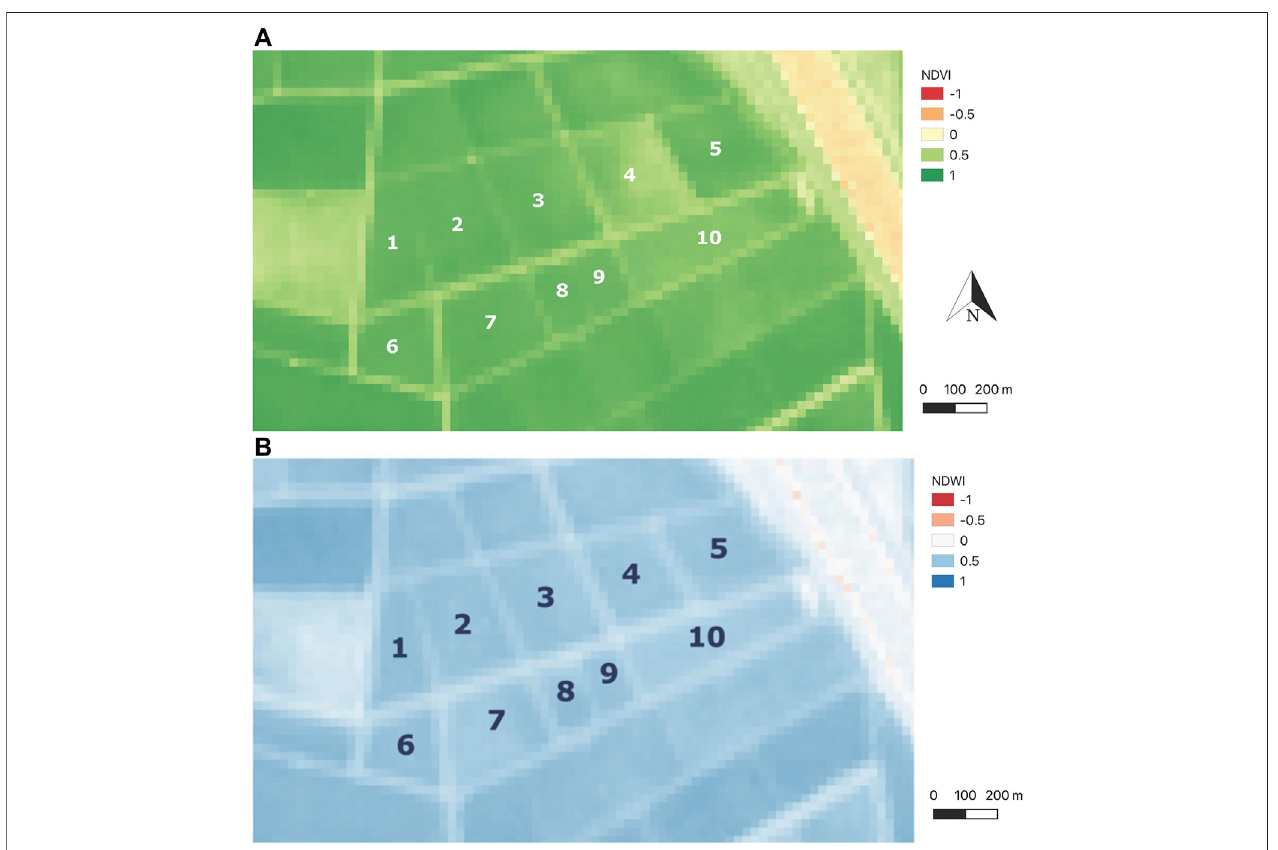
FIGURE3| Mapsofthe (A) NDVIand (B) NDWIfortheselectedrice fi eldsinQuintadoCanal,onJuly8,2020.DataarefromSentinel-2A,at20 mspatialresolution.